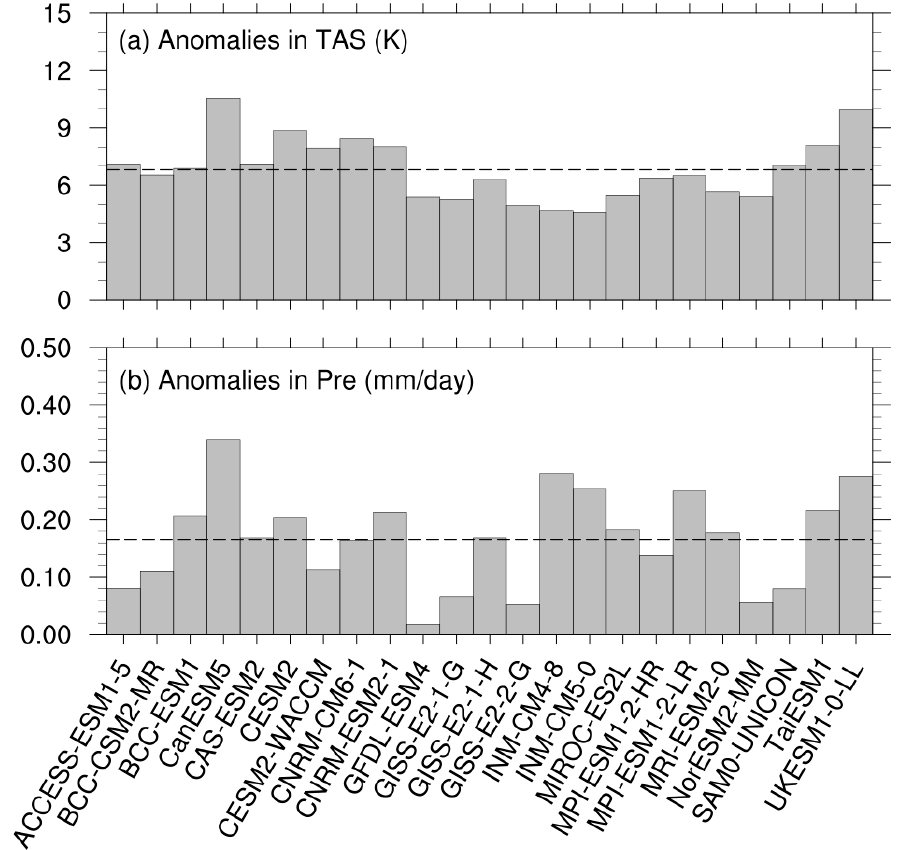
Figure 1. Global averaged anomalies in ( a ) surface air temperature (TAS, units: K) and ( b ) precipitation (Pre, units: mm day − 1 ) for the CAS-ESM2 and the 22 CMIP6 models. The dashed lines represent the multi-model ensemble values (MME).